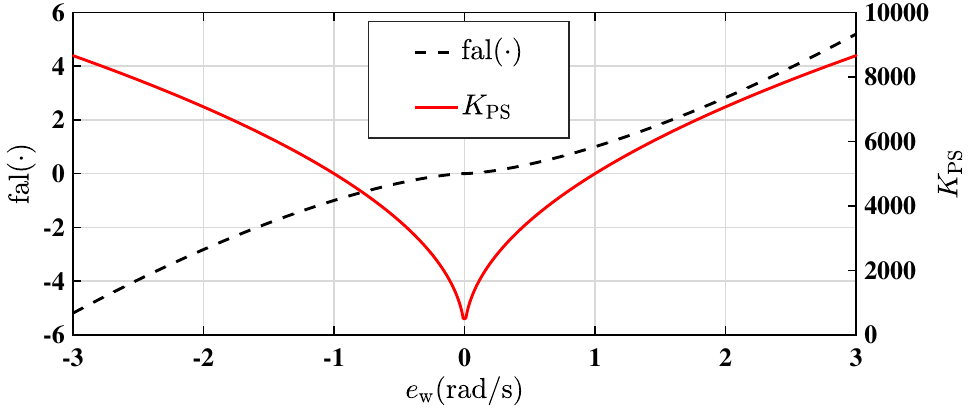
Figure 3. The characteristic curves of fal ( e w , α w ) and K PS